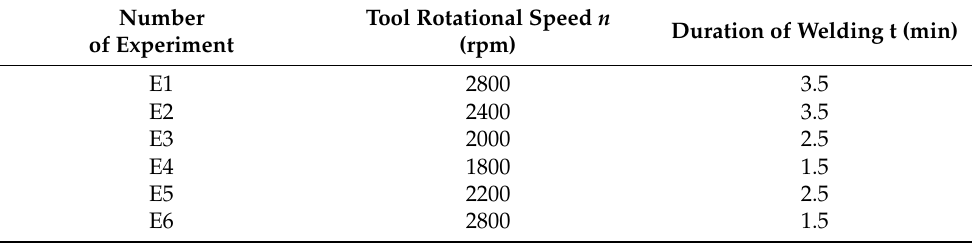
Table 2. Experimental